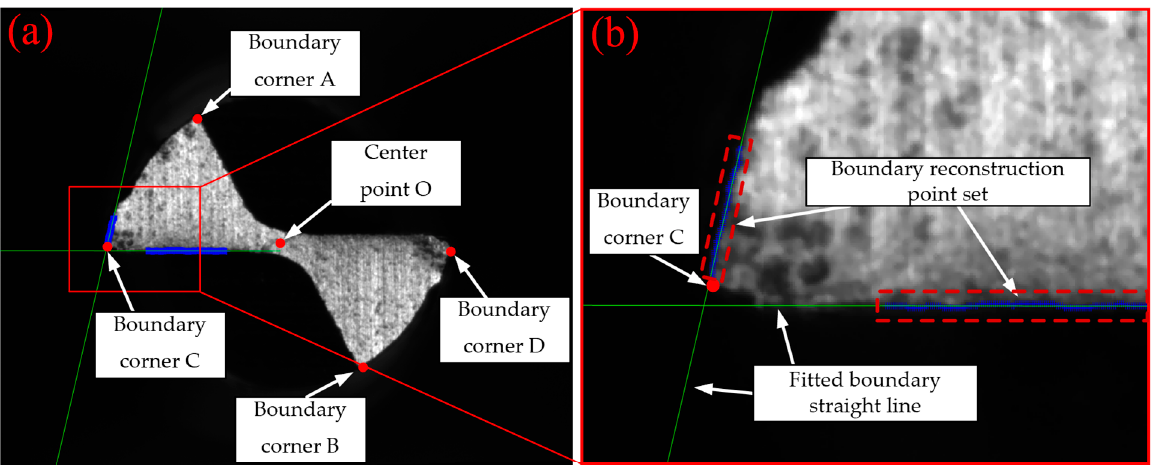
Figure 15. Tool tip wear region boundary reconstruction in rotated original wear image: ( a ) overall image of the wear region boundary reconstruction; ( b ) detail image of the wear region boundary reconstruction.